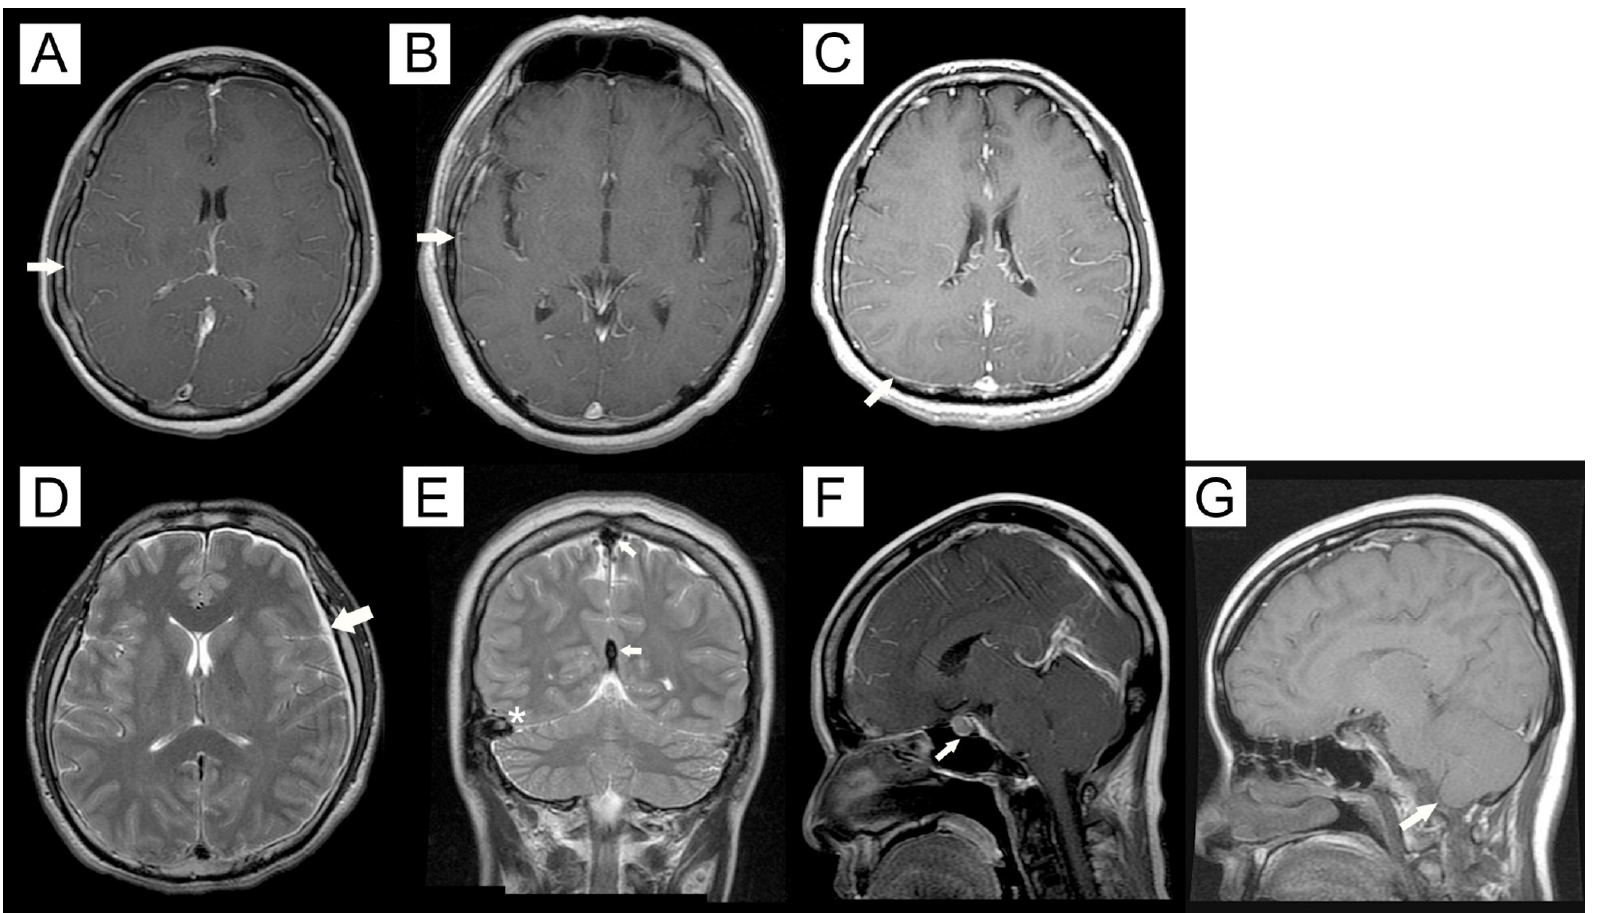
Figure 3. MRI findings of intracranial hypotension. Panels ( A – C ) were T1-weighted images with contrast enhancement (arrows). Panel ( A ) revealed generalized enhancement of the meninges, while panel ( B ) showed partial enhancement of the frontotemporal region, and panel ( C ) showed partial enhancement of the occipital region. Panel ( D ): subdural fluid accumulation on the left hemisphere (arrow) on T2-weighted image. Panel ( E ): engorgement of the superior sagittal sinus (arrows) and transverse sinus (asterisks) on T2-weighted image. Panel ( F ): T1-weighted image with contrast enhancement demonstrates pituitary hyperemia (arrow). Panel ( G ): T1-weighted image without contrast shows brain sagging with cerebellar tonsil herniation (arrow).